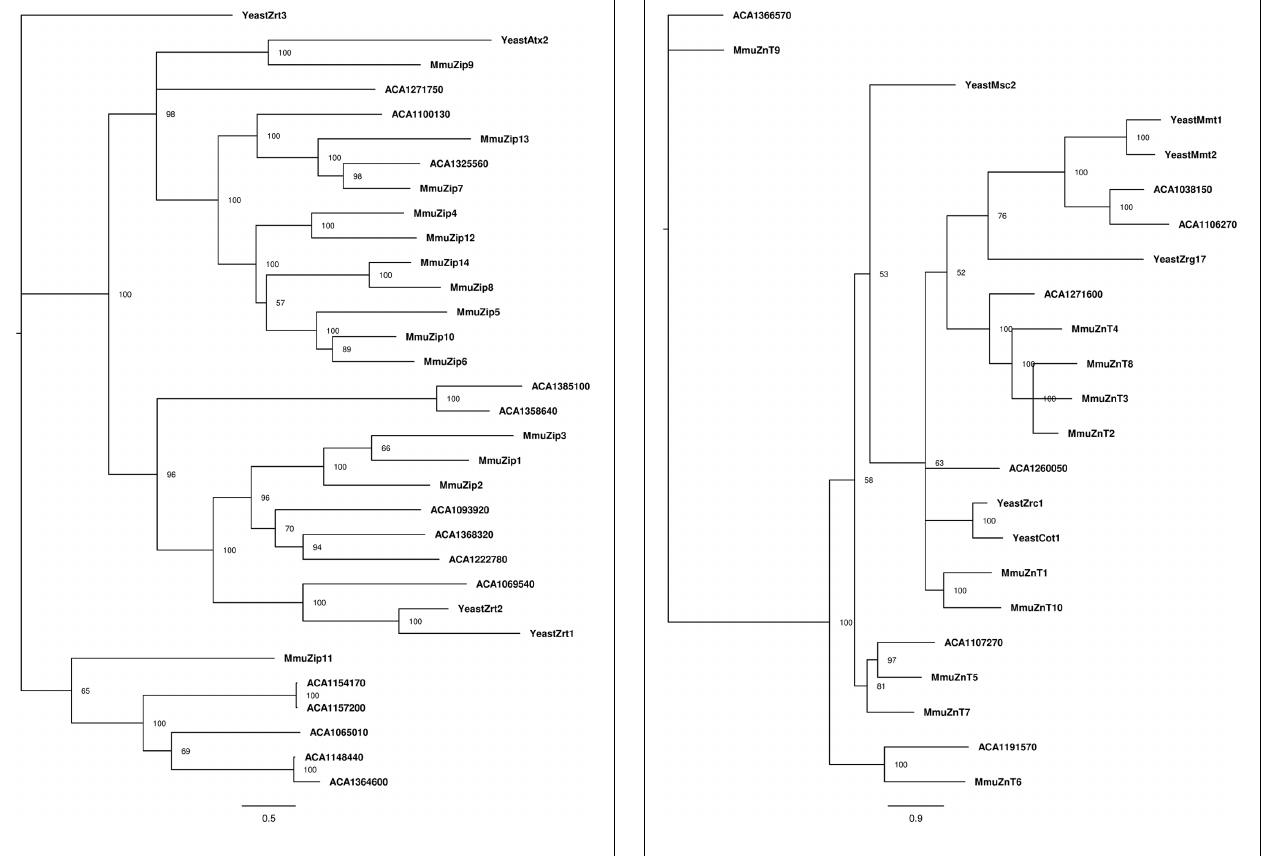
FIGURE 3 | Phylogenetic reconstruction of ZIP zinc proteins from mouse, amoeba, and Saccharomyces cerevisiae . Sequences retrieved from Uniprot and AmoebaDB based on the presence of the Pfam domain ZIP (PF02535) were aligned with Clustal Omega, and the best evolutionary model was selected based on ProtTest. Bayesian analysis was conducted and the tree was drawn using FigTree. The percentage of replicate trees in which the associated taxa is shown next to the branches. The scale bar represents substitutions of amino acids per site.